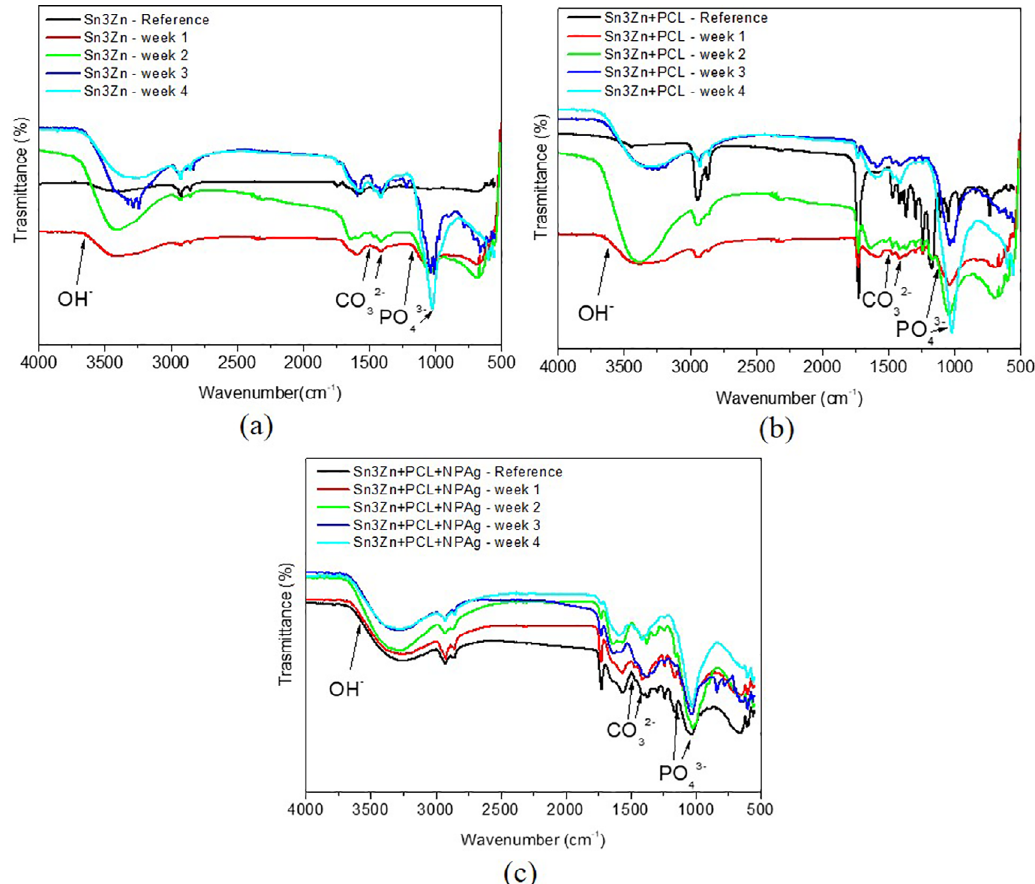
Figure 8. FTIR analysis after bioactivity assay. (a) Sn3Zn-ribbon, (b) Sn3Zn+PCL-ribbon and (c)